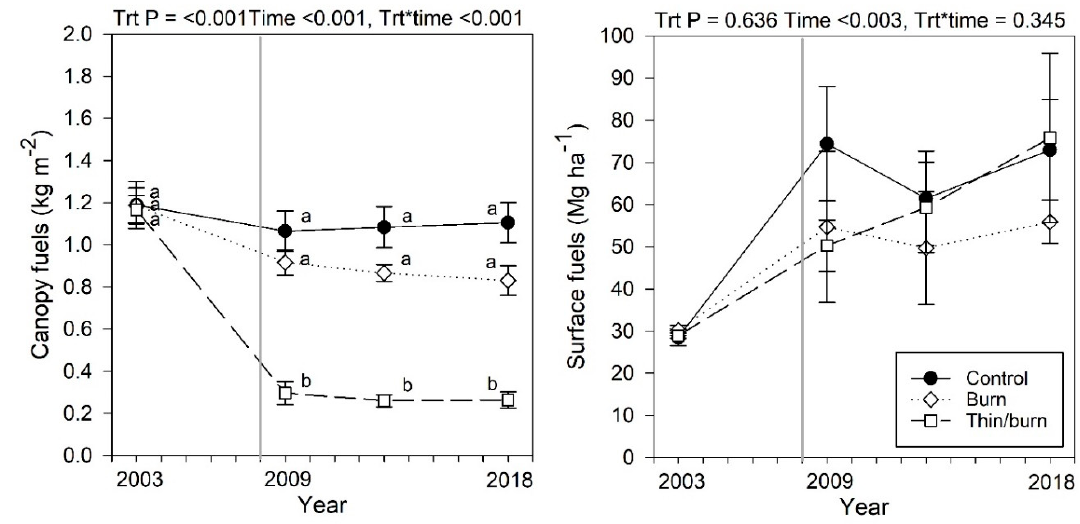
Figure 3. Mean canopy fuels (crown fuel load) and surface fuels (sum of forest floor and 1–100-h time lag classes) plotted through time for both treatments and control. Bars represent 1 standard error of the mean ( n = 4). The vertical line denotes when all treatments were completed (2008). Data comparisons are among treatments and different letters denote a significant treatment effect within a year ( p ≤ 0.05).